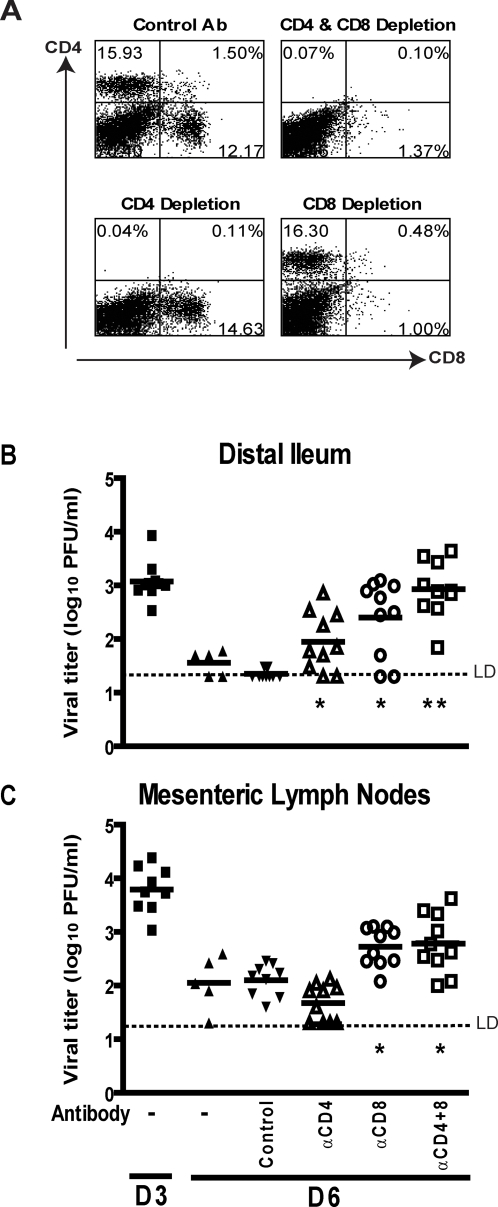
CD4 and CD8 T cells are required for clearance of primary MNV infection at 6 days post-infection.(A) Representative flow cytometric analysis of CD4 and CD8 staining on splenocytes harvested from control and immunodepleted WT mice 6 days post-infection with MNV1.CW3. Viral titer in (B) distal ileum and (C) MLN after treatment with the indicated antibodies. Results are pooled from two independent experiments with 3–5 mice per group in each experiment. (**) indicates p<0.0001, (*) indicates p<0.05. LD indicates the limit of detection.